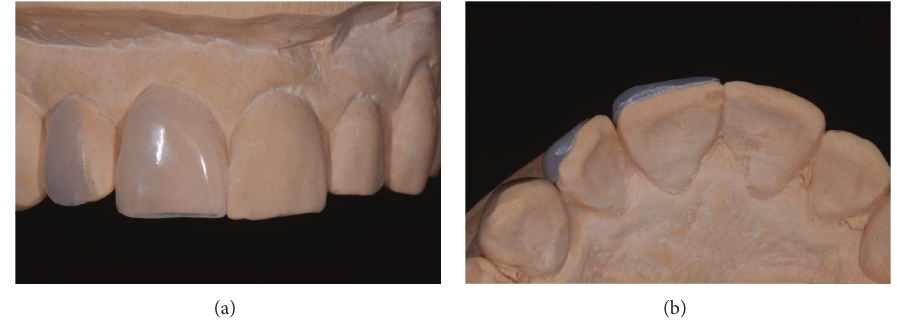
Figure 3: (a) Frontal view of the mock-up made in PMMA resin of teeth 11-12. (b) Occlusal view of the same mock-up.